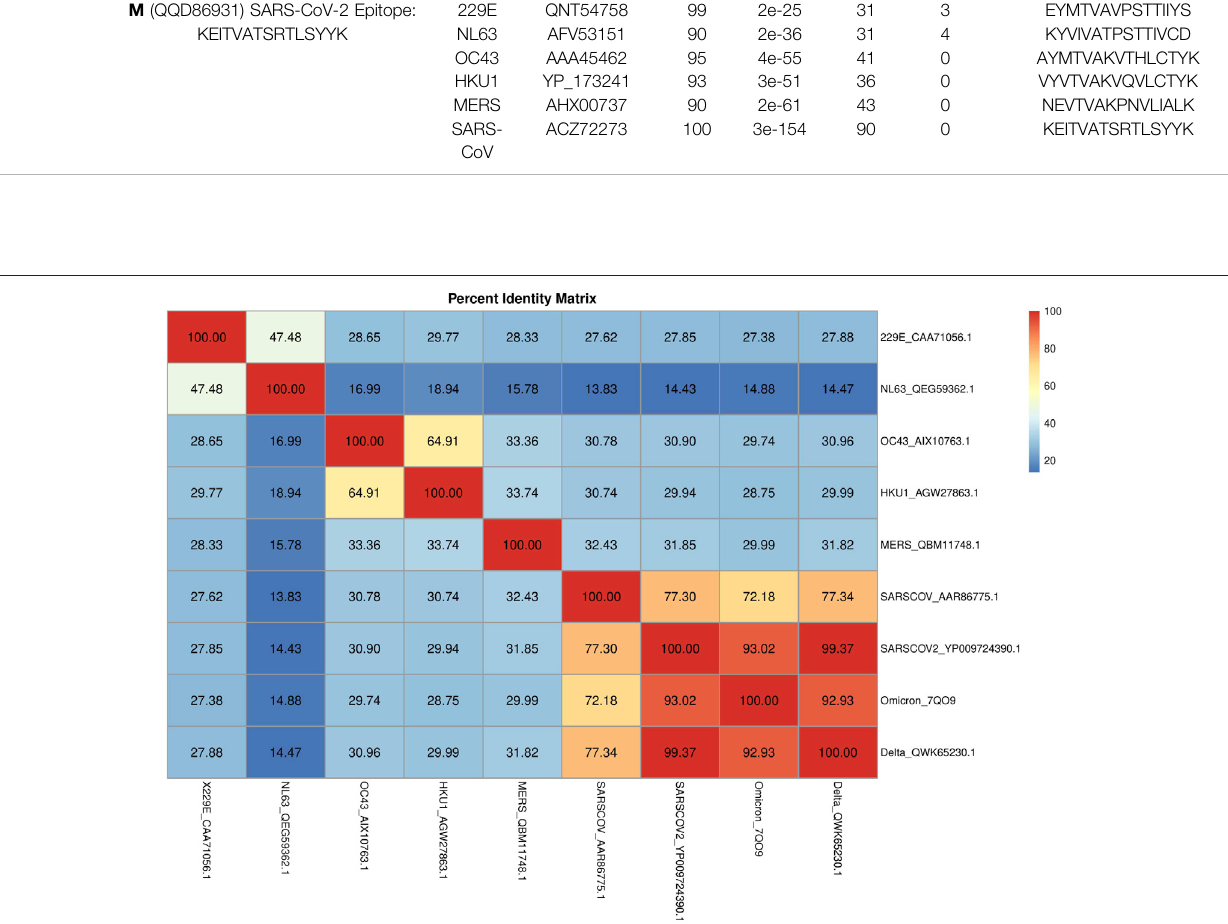
Frontiers in Genetics |